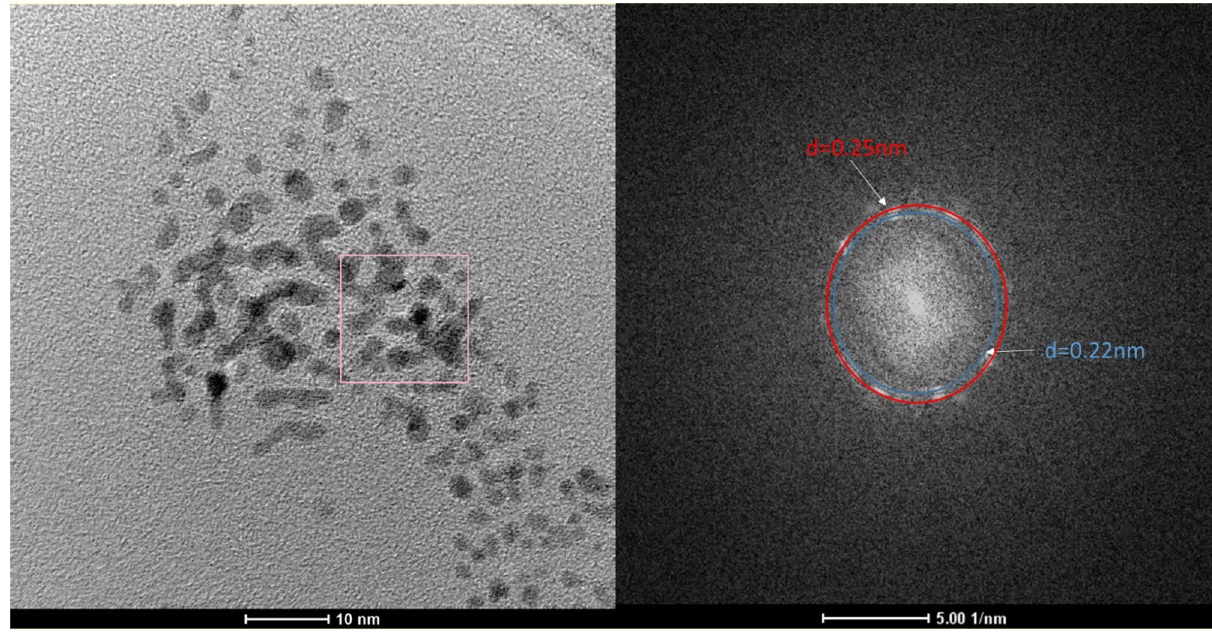
Figure 2. HR-TEM analysis of the PtNPs obtained in batch reactor. Conditions: [Pt(IV)] = 1 × 10 −4 M, [TSC] = 1 × 10 −3 M, synthesis time 60